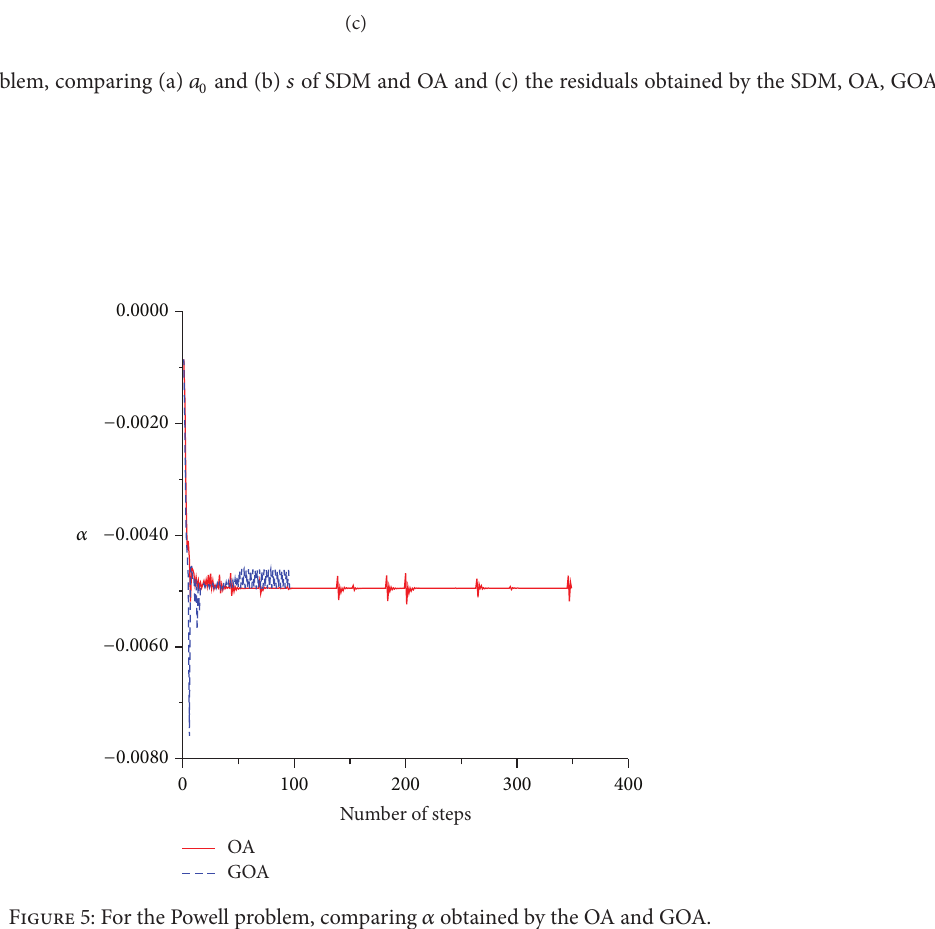
Figure 5: For the Powell problem, comparing 𝛼 obtained by the OA and